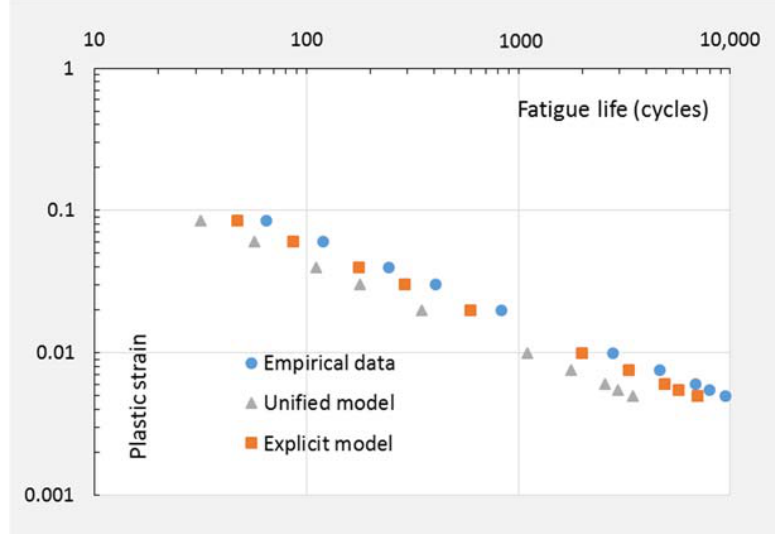
Figure 8. Predicted life and empirical data of stainless steel 316 for pure fatigue. Table 7. The average errors and prediction ratios given by the unified model and the explicit model.